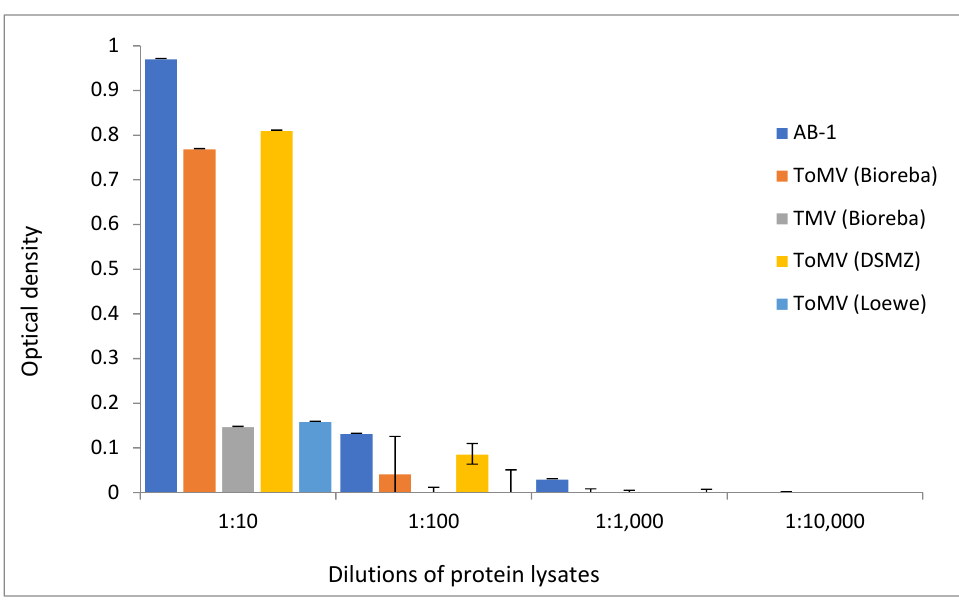
Figure 2. Sensitivity of the compared antibodies in the detection of ToMV by the ELISA assay in differently diluted protein lysates from ToMV-infected tomato plants (mean values and standard deviation error bars).